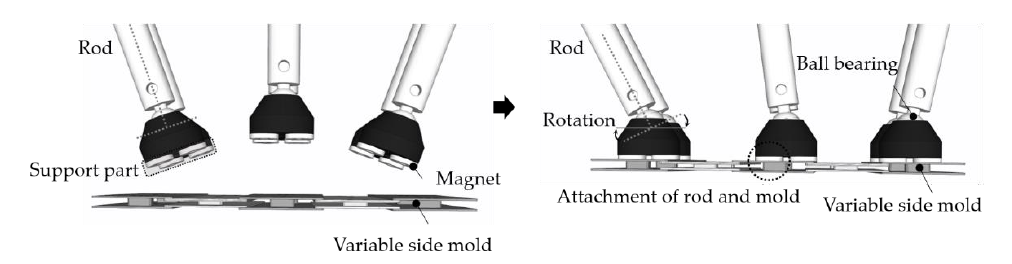
Figure 13. Rotation of the rod.